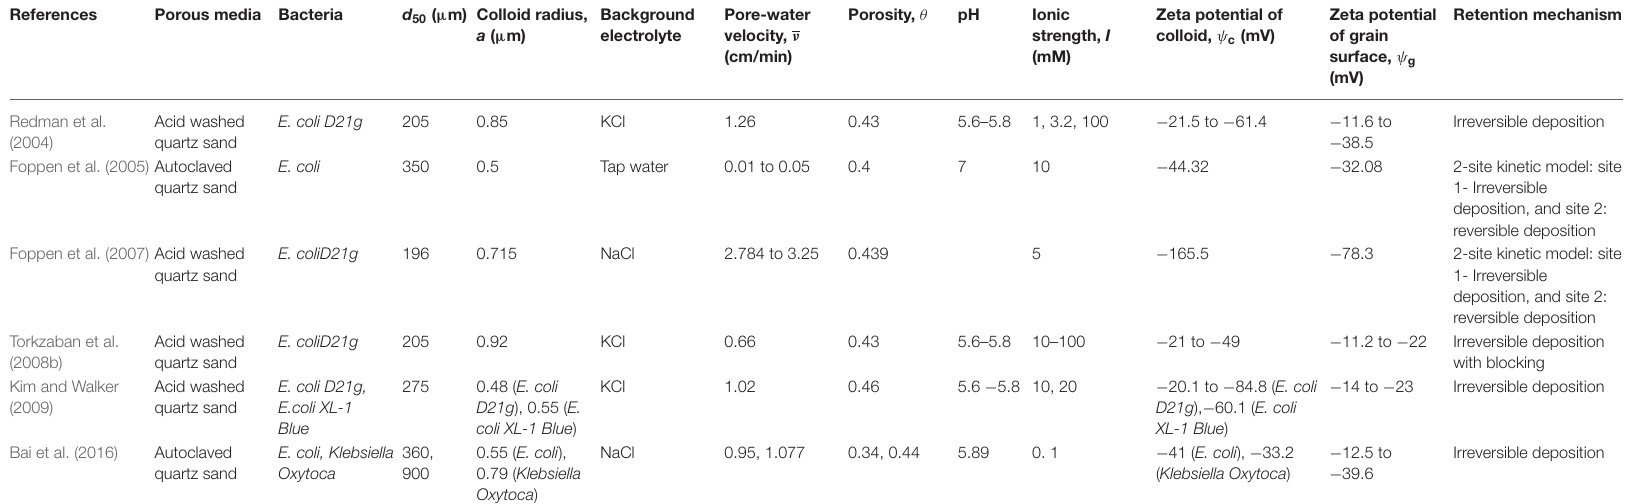
TABLE 2 | Experimental conditions in papers selected to analyse deposition of